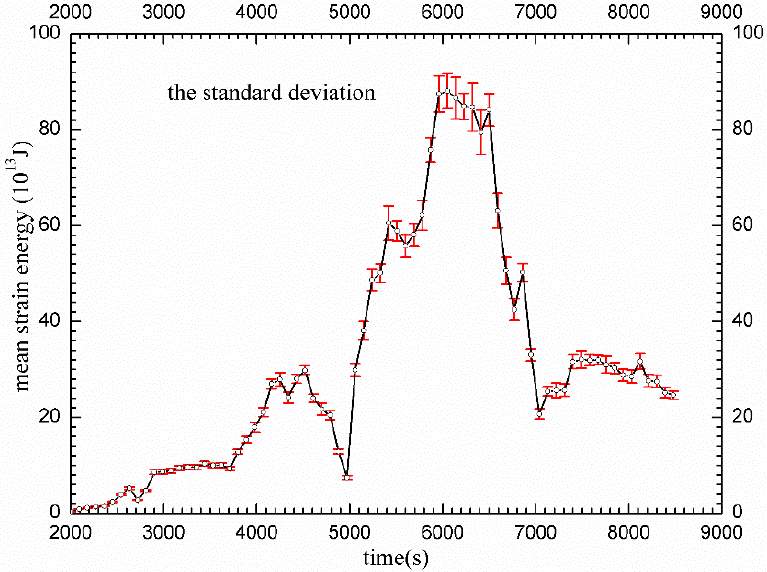
Figure 9. The mean and standard deviation values of strain energy over time of three repeated experiments.